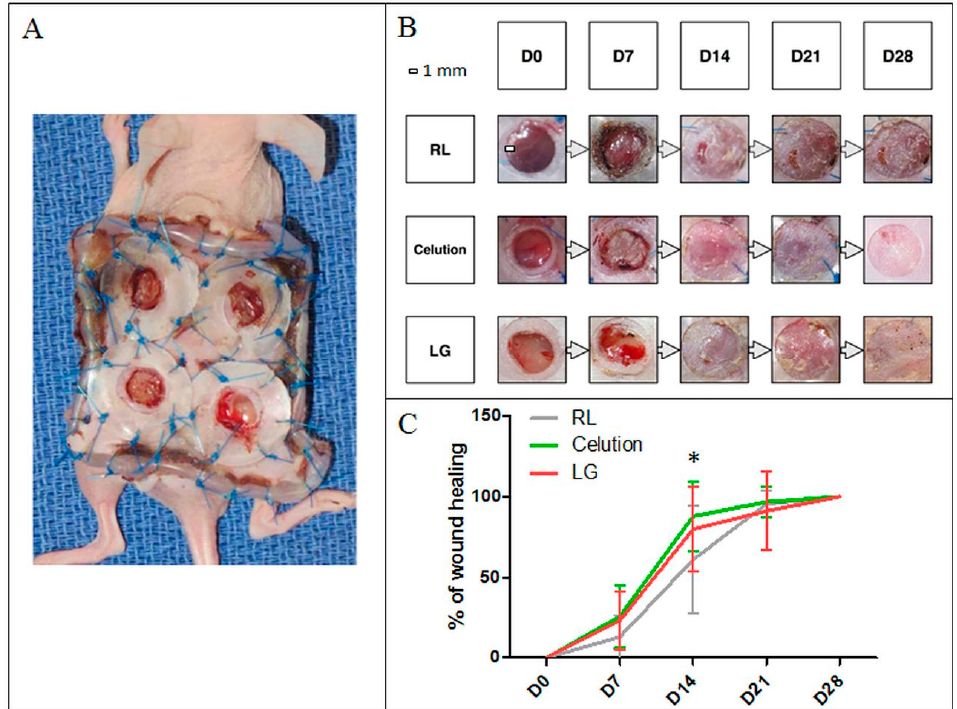
Figure 7. Testing of the angiogenic ability of SVF produced with both protocols in a mouse model of subcutaneous ischemia versus placebo. SVF was produced from the same AT sample (n = 1) with both processes and injected into the wound edges of six mice per group. ( A ) Representative image of the mouse model of subcutaneous ischemia on day 0 (D0). The control consisted of RL in injections in four mice. Wound healing was quantified at D7, D14, D21, and D28 post-injection by analysis of standardized images. ( B ) Representative images of wound closure for each group and for each time. ( C ) The kinetics of wound healing did not di ff er between the LG and Celution groups. On D14, wound healing was significantly greater in the LG and Celution groups compared to placebo, with respective p -values < 0.05 and < 0.001. No di ff erence was observed between the three groups at D7, D21, and D28.*: p <